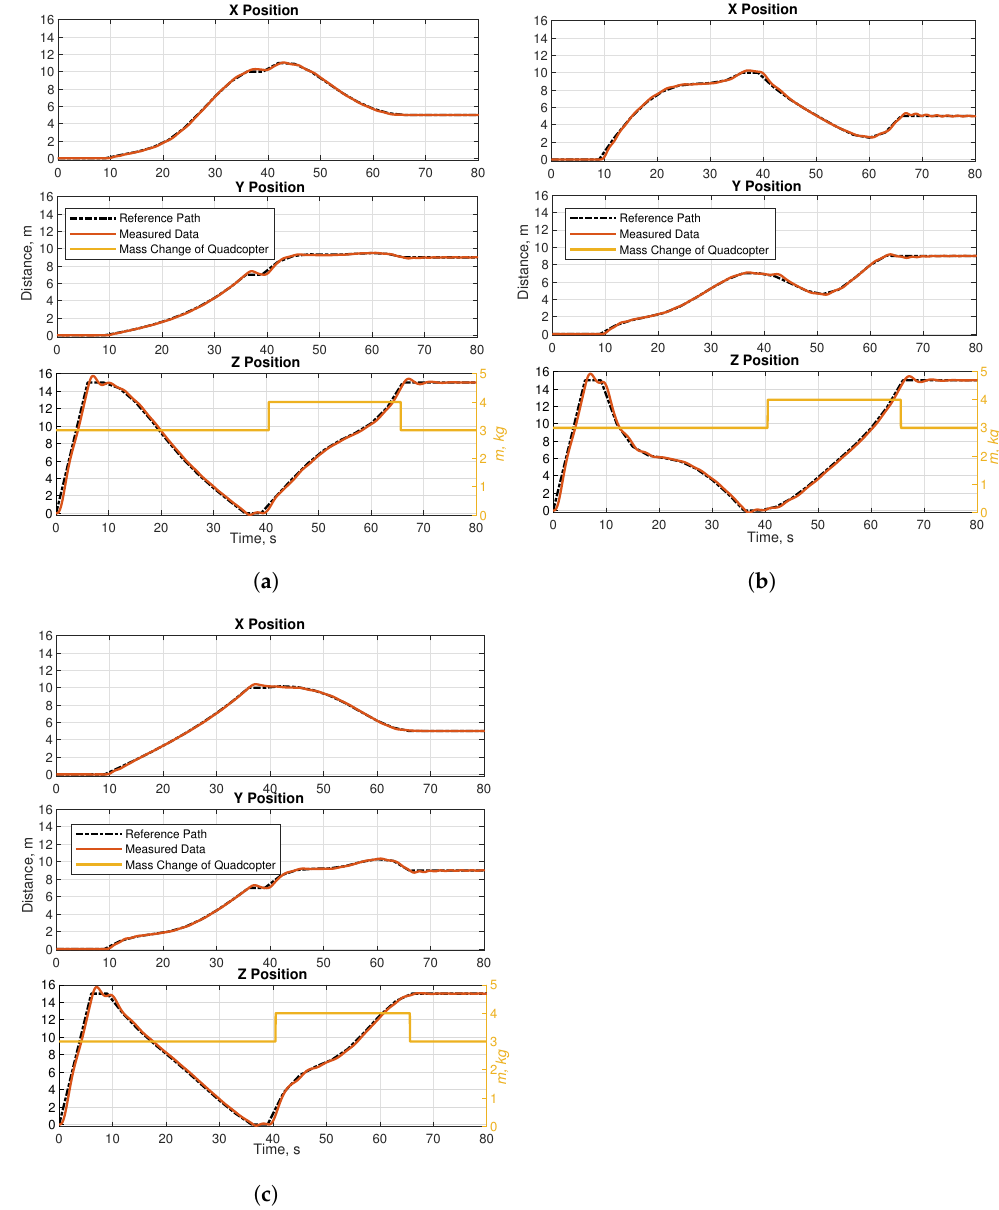
Figure 13. The path-tracking performance of quadcopter for Map 2 ( a ) using PSO, ( b ) using GWO, and ( c ) using hybrid